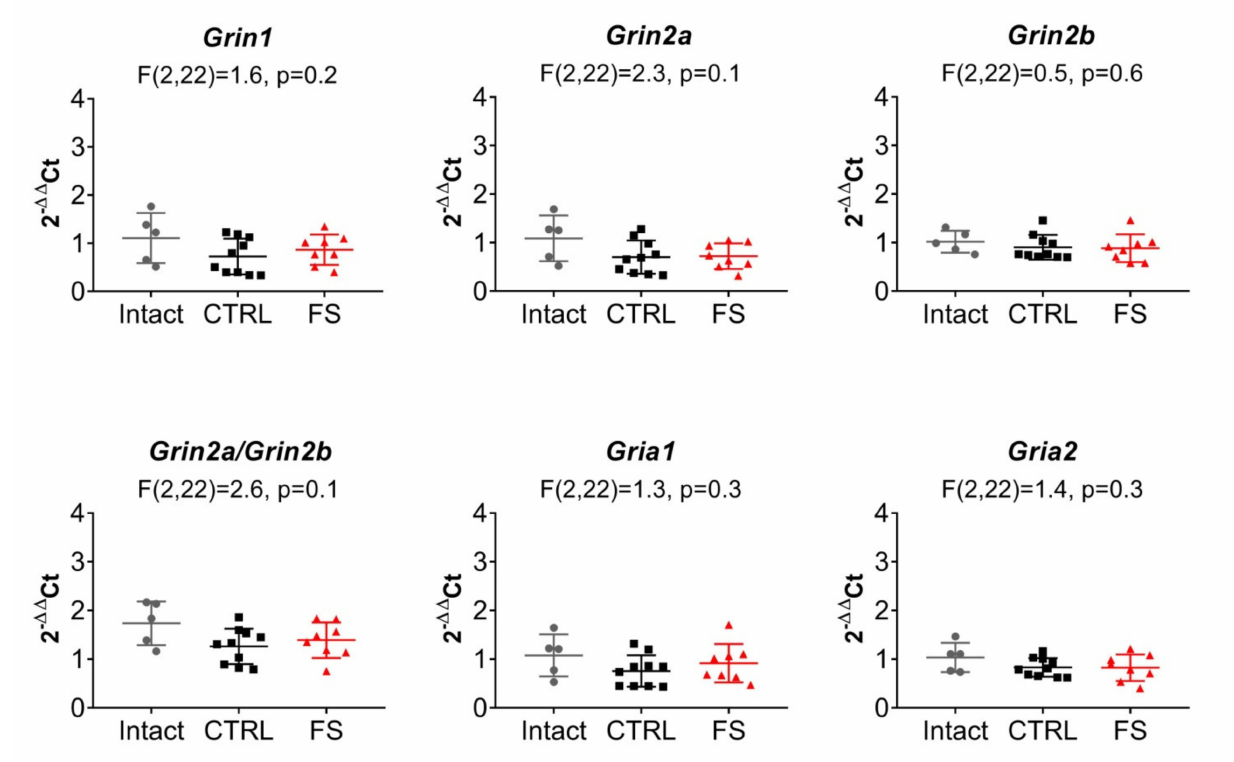
Figure 7. The relative expression of the Grin1, Grin2a, Grin2b, Gria1, Gria2 genes, and Grin2a/Grin2b ratio in the dorsal hippocampal area after febrile seizures. CTRL—control group; FS—experimental group. One-way ANOVA followed by Tukey’s post hoc multiple comparison tests. Data are presented as a mean with a standard error of the mean. Each dot (circle, rhombus, square) represents a value obtained in individual